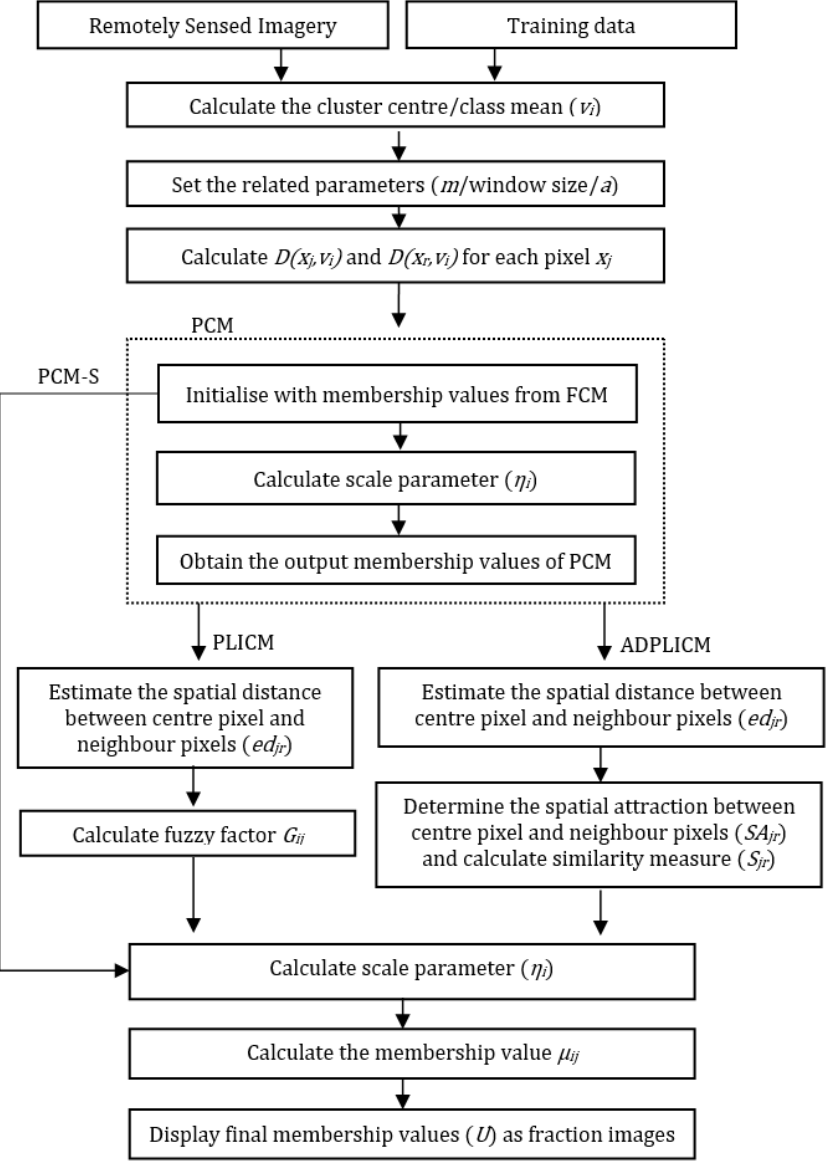
Figure 3. The flowchart for the design and implementation of PCM-based local spatial information classification algorithms.